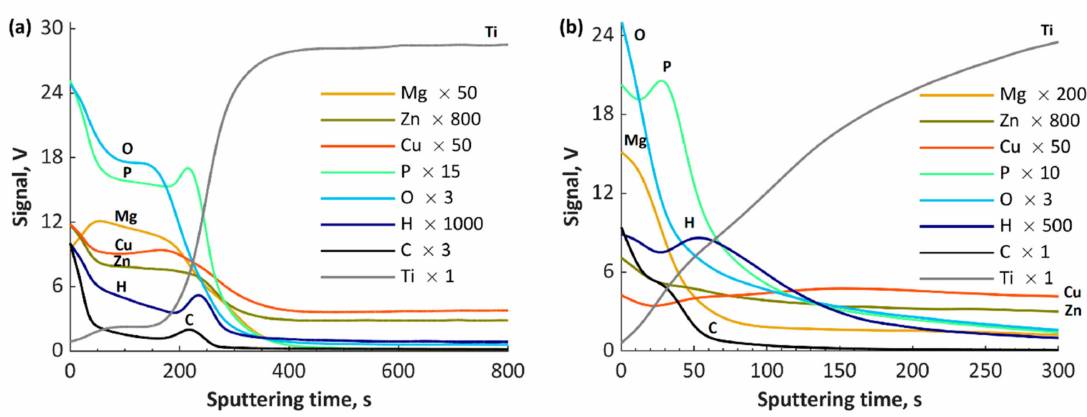
Figure 11. GDOES depth profiles of the coatings: ( a ) TiZnCuMg-35; and ( b )